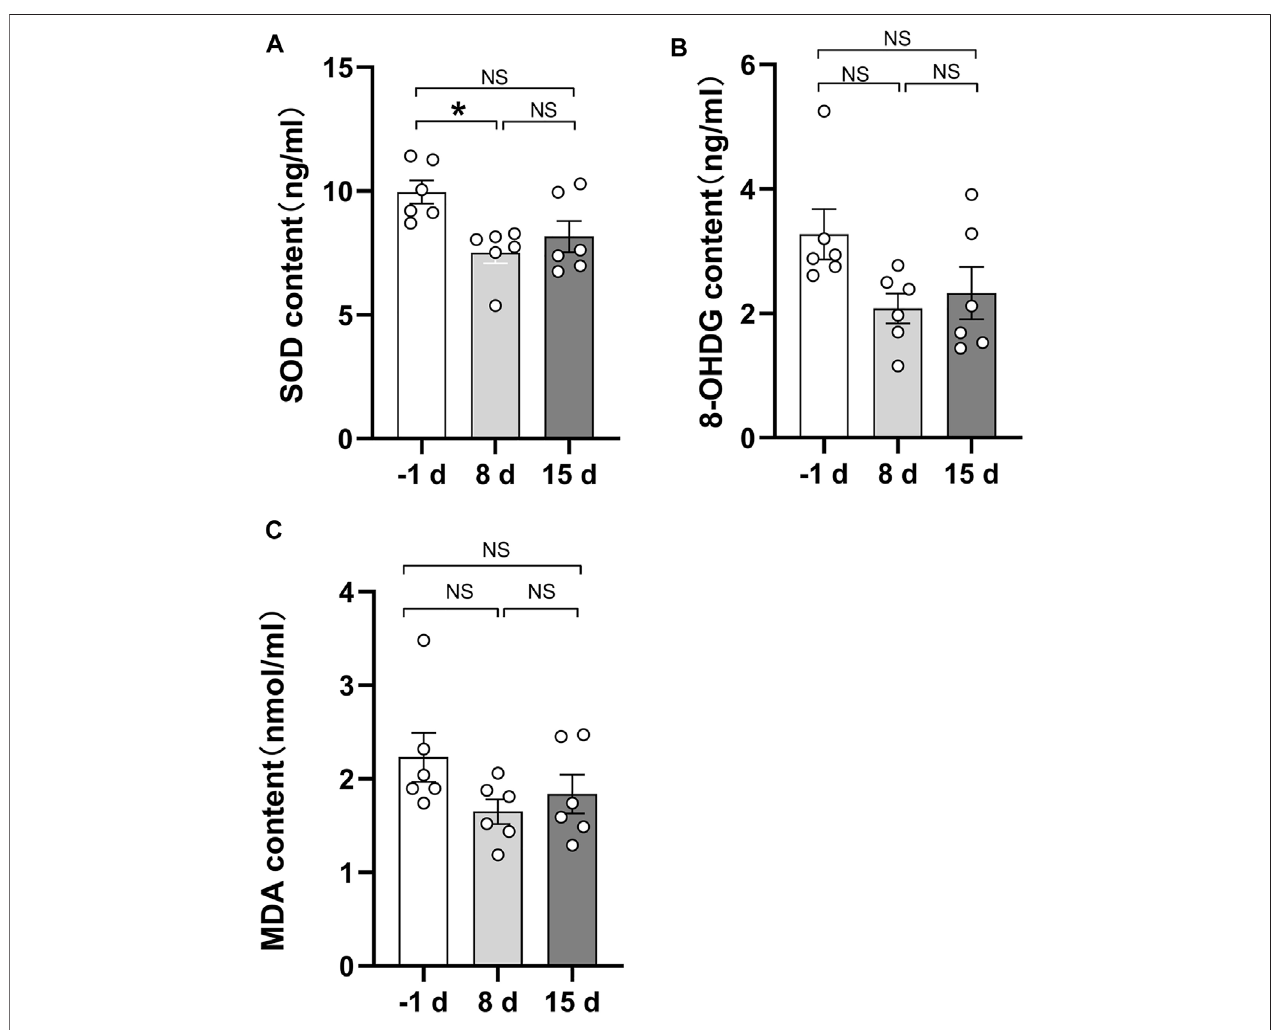
FIGURE6| Quantitativecomparisonofserumbiochemicalindicatorsduring15 daysofhead-downbedrest. (A) Changesofserumsuperoxidedismutasecontent during 15 days of head-down bed rest. Data represent mean ± SEM. Signi fi cant values are determined as * p < 0.05 (Tukey ’ s multiple comparisons paired test). (B) Changes of serum 8-hydroxydeoxyguanosine during 15 days of head-down bed rest. Data represent mean ± SEM. (Tukey ’ s multiple comparisons paired test). (C) Changes of serum malondialdehyde content during 15 days of head-down bed rest. Data represent mean ± SEM. (Tukey ’ s multiple comparisons paired test).